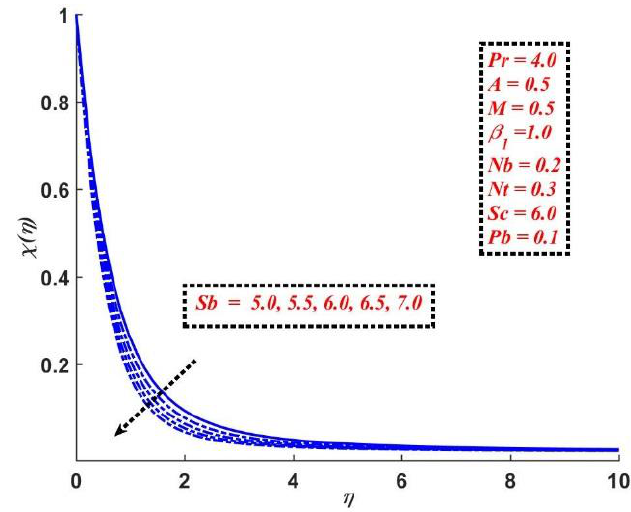
Figure 12. Influence of the bio-convection Schmidt number on χ ( η ) .